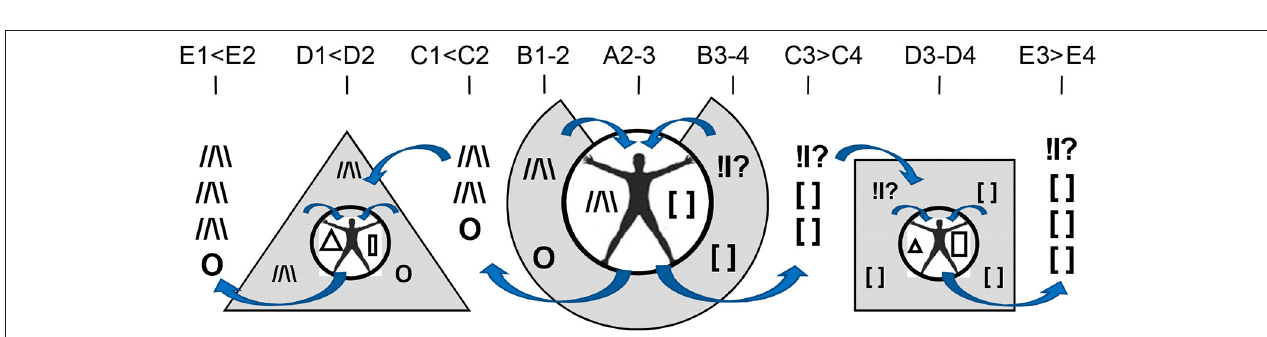
FIGURE 2 | An illustration of the concept of Specialized Extended Phenotype (SEP ). People with two types of bio-behavioral (dis)abilities (A) interact with the environment (B) requiring four types of tasks and corresponding abilities. Individuals produce actions (C) in a biased way, primarily in line with their specific capacities, and, therefore, not following all the requirements. This, in turn, contributes to SEPs as the more specialized parts of the environmental infrastructure (D) providing support for specific (dis)abilities. SEP-compatible actions of an individual (C,E) , therefore, contribute to the existence and development of specialized “industries” in the environmental infrastructure (D) , which, in turn, reinforce more actions of this type. Geometric shapes refer to both, socially desirable functional actions and to dysfunctional actions (e.g., seen in addiction) that are entangled with SEPs supporting these actions. In this example, two types of SEPs are developed: supporting orientation to novelty